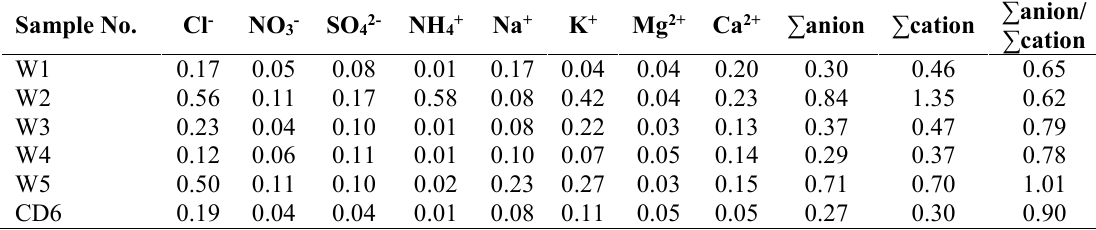
Table 2 Particulate equivalent concentrations of ions, µEq Sample